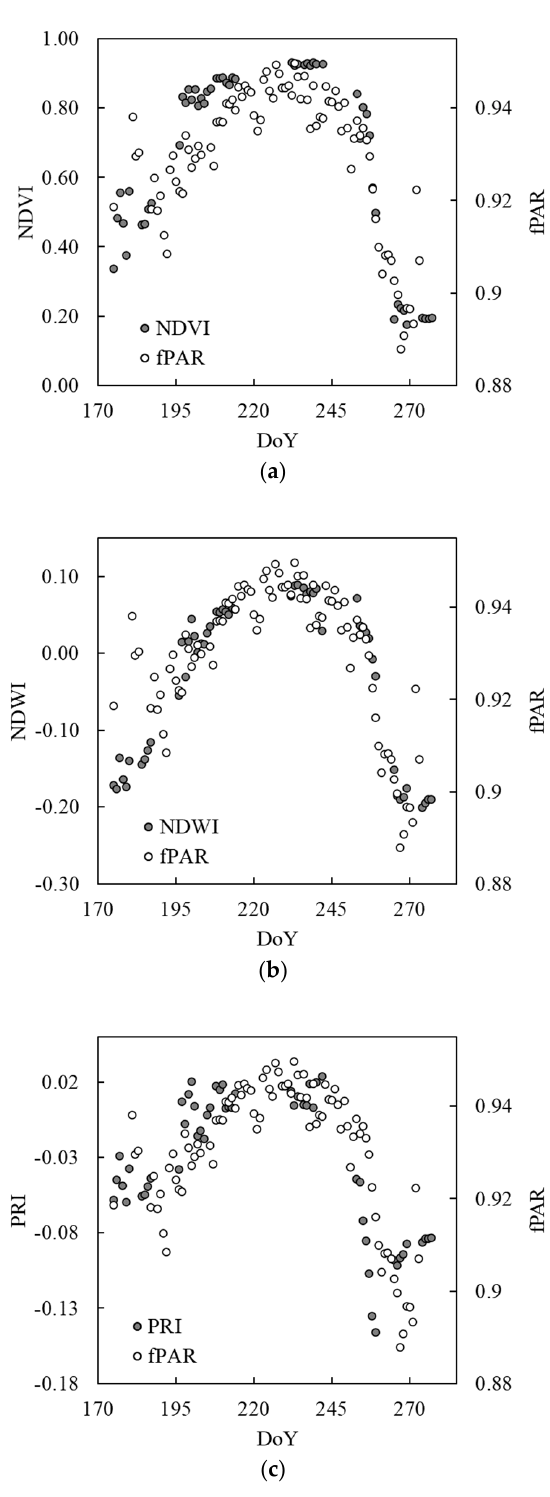
Figure 5. Seasonal trajectories of ( a ) NDVI, ( b ) NDWI, and ( c ) PRI compared with the fraction of photochemically active radiation absorbed by land surface (fPAR) of the 2015 growing season that was measured using the eddy covariance system.